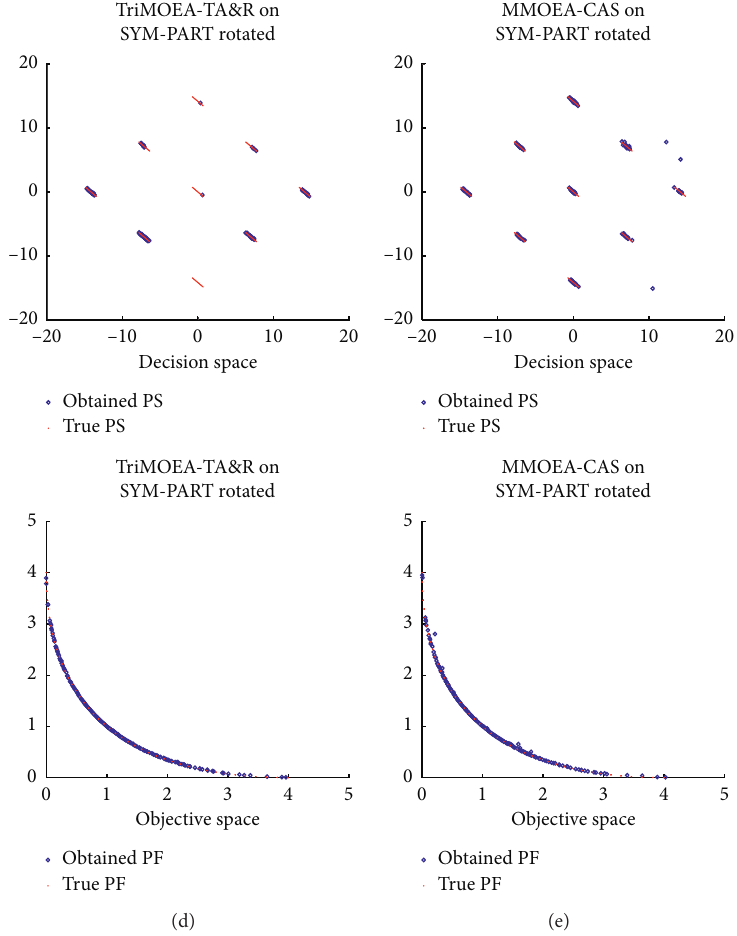
Figure 2: The final populations obtained in decision and objective spaces on SYM-PART